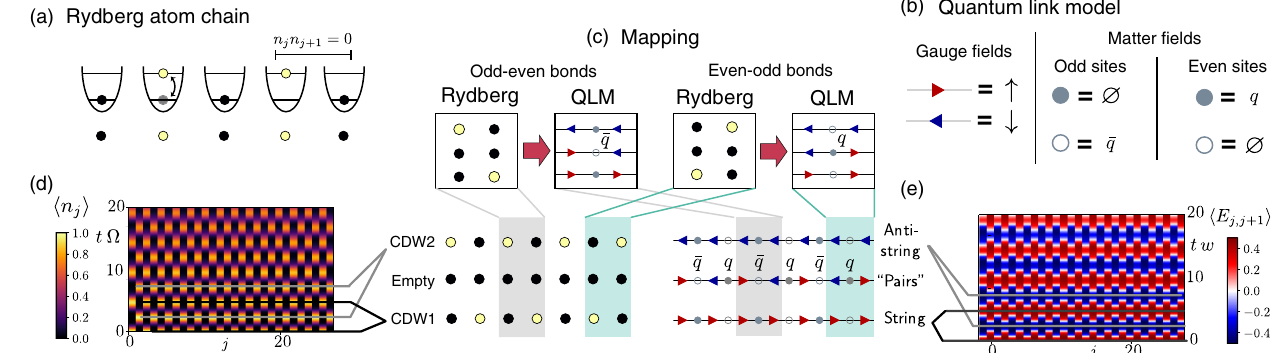
FIG. 1. Gauge-theory interpretation of Rydberg atom quantum simulations. (a) Schematics of a Rydberg atom chain. Each potential well of the optical lattice hosts a single atom, which can be in either the ground (black) or excited Rydberg (yellow) state. These two levels are coupled by a laser field. The Rydberg blockade prevents the simultaneous excitations of neighboring atoms. (b) Degrees of freedom of a U(1) LGT in the spin- 1 = 2 quantum link model (QLM) formulation. Gauge fields are represented by spin variables residing on links. Matter fields are represented by Kogut-Susskind fermions: an occupied site corresponds to the vacuum on odd sites and to a quark q on even sites. An empty site, instead, corresponds to the vacuum on even sites and to an antiquark ¯ q on odd sites. (c): Mapping between Rydberg-blockaded states and configurations of the electric field constrained by the Gauss law in the QLM. Because of the staggered electric charge, the allowed configurations of the electric field depend on the link, as illustrated. The two so-called charge- density wave configurations “ CDW1 ” and “ CDW2 ” of the Rydberg atom arrays are mapped onto the “ string ” and “ antistring ” states, respectively, characterized by uniform rightward or leftward electric fluxes. The empty configuration with all Rydberg atoms in their ground state is mapped to a state filled by adjacent particle-antiparticle pairs. (d) Time evolution of the Rydberg array governed by the effective Hamiltonian H in Eq. (2), starting from the CDW1 state. The plot shows the space and time resolved population h n j i of the FSS ˆ E excited Rydberg atoms. (e) Evolution of the expectation value of the electric field operator j;j þ 1 in the QLM. These dynamics map exactly onto the ones shown in (d) via the mapping illustrated in (c). The thin lines highlight the oscillation between CDW1, CDW2 [left, bottom of (c)] or string and antistring (right) states. In these simulations, L ¼ 24 and δ ¼ m ¼ 0